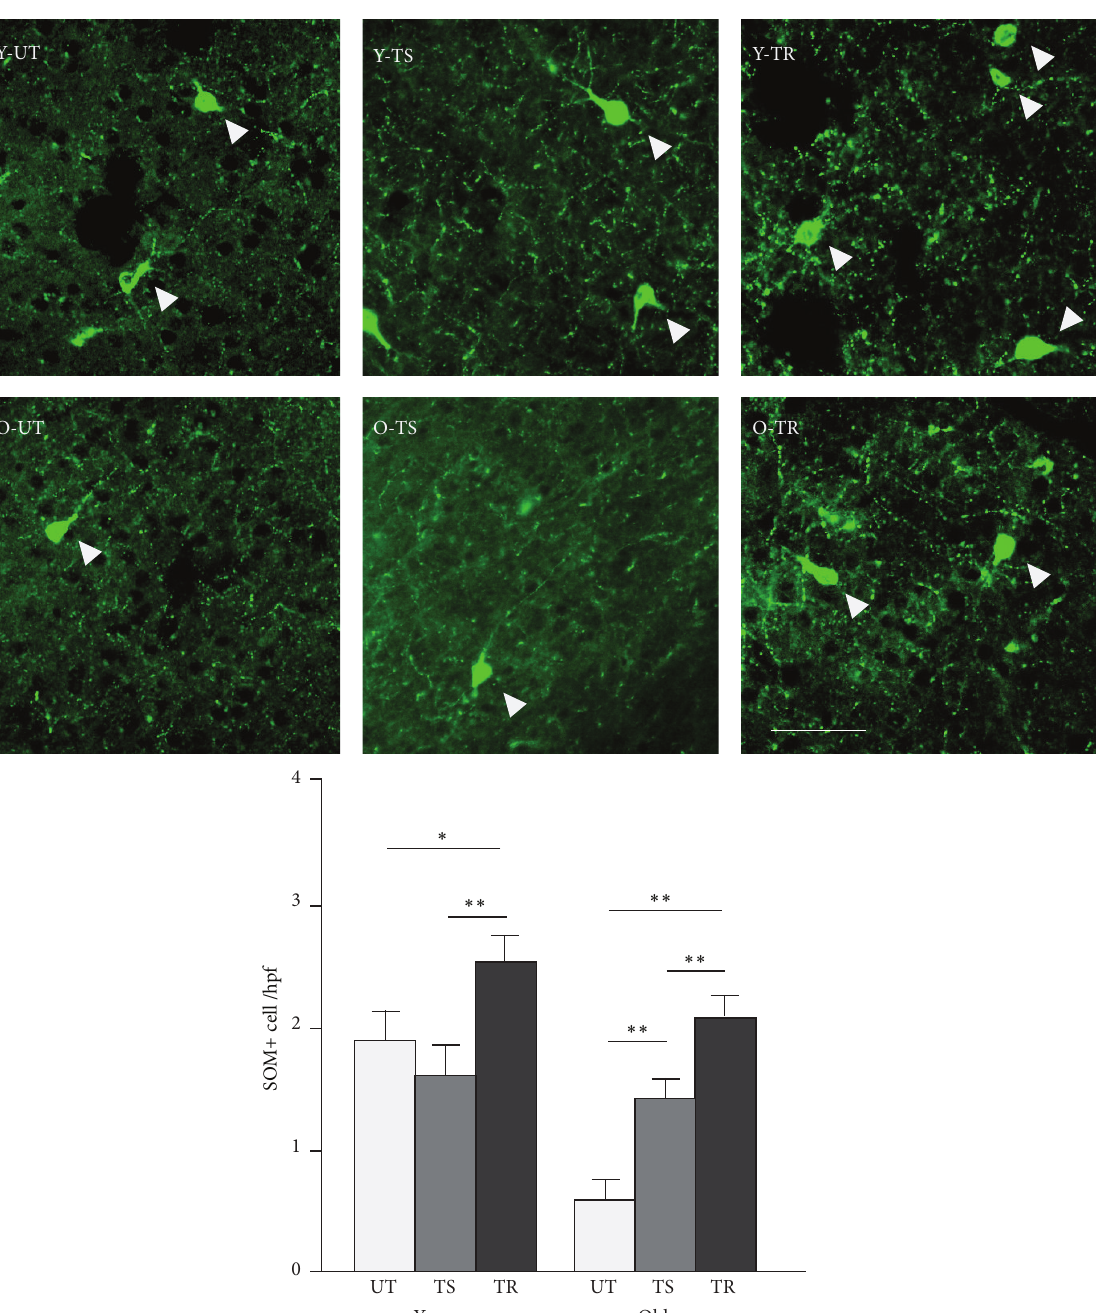
Figure 6: Effect of training and rivastigmine on the number of SOM+ cortical interneurons. Quantitative analysis of the average number in A1 of SOM immunoreactive cells per high power field (hpf) in all experimental groups. Top panel: representative high power photomicrographs of representative sections in all groups. Bottom panel: average SOM+ cell counts in all groups (all layers pooled). Number of hemispheres examined: Y-UT = 10, Y-TR = 8; O-UT = 8, O-TR = 8; number of micrographs/hemispheres: 7. ∗ 𝑝 < 0.05 , ∗∗ 𝑝 < 0.01 , 𝑡 -test. Scale bar: 50 𝜇 m.